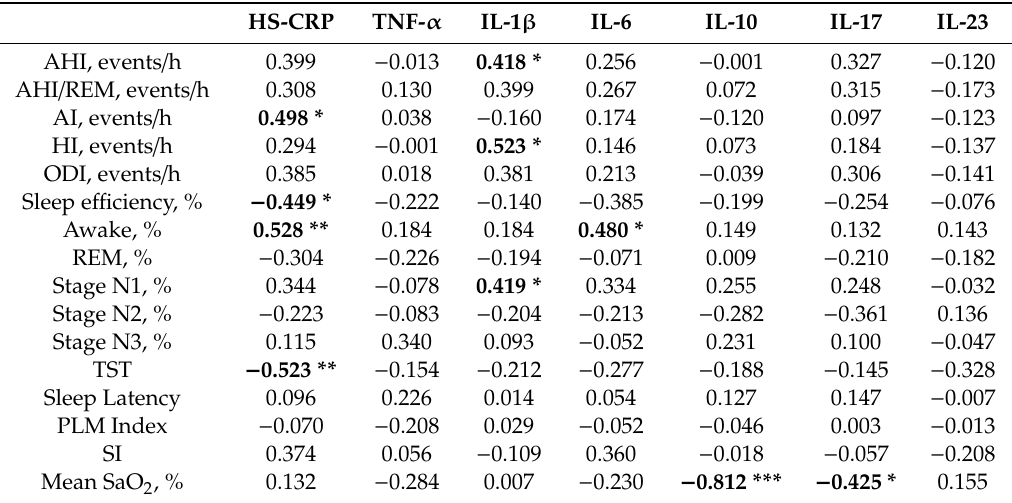
Table 5. The association between inflammatory cytokines and PSG